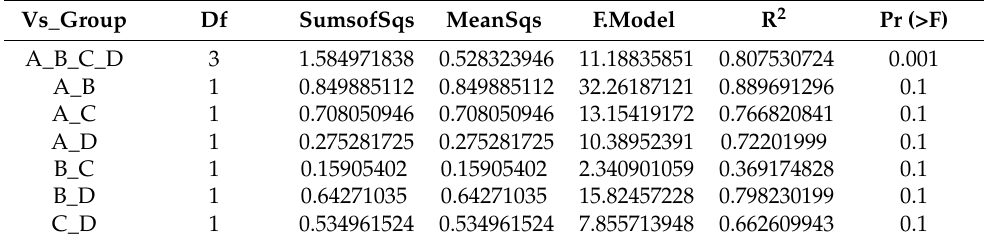
Df represents the degree of freedom; SumsofSqs represents total variance; MeanSqs represents mean variance; F.model represents test value; R 2 represents degree of differences; Pr stands for p value, and less than 0.05